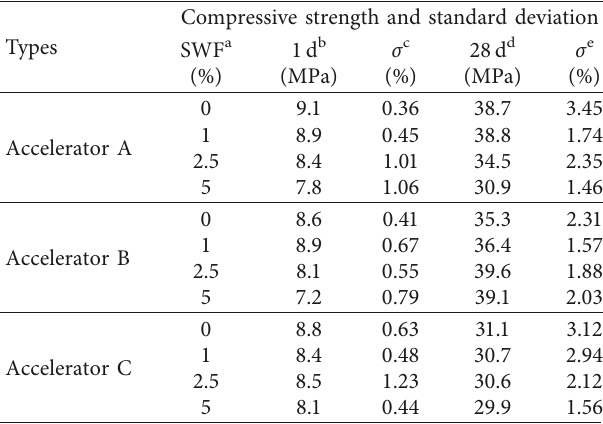
Table 4: 1d and 28d compressive strength of the modified ac- celerator and standard deviation of compressive strength.